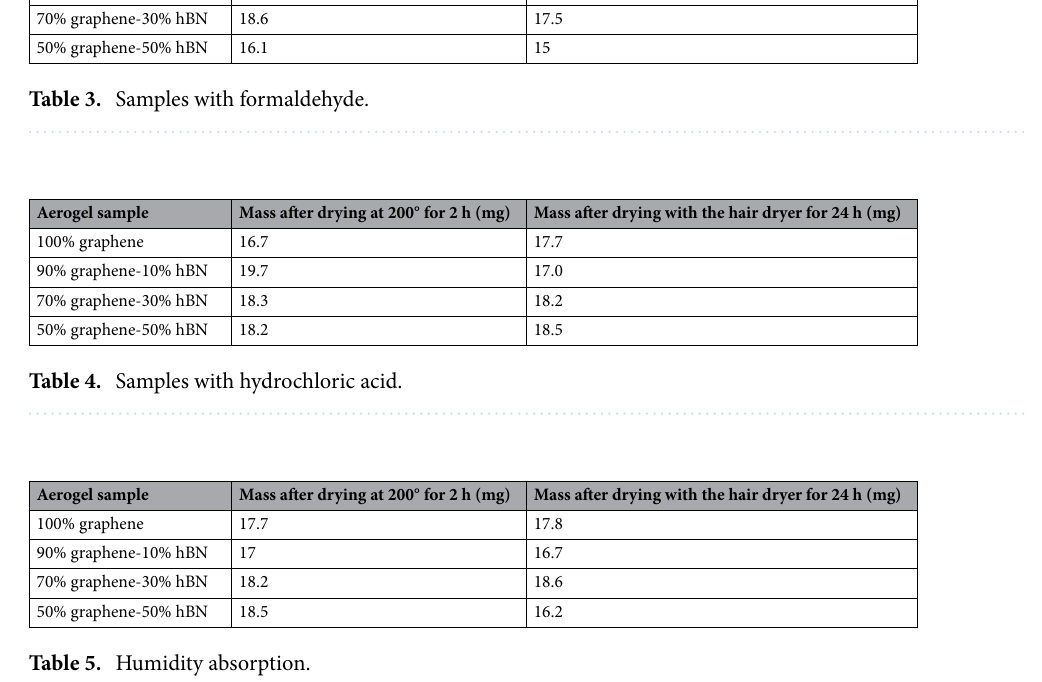
Table 5. Humidity